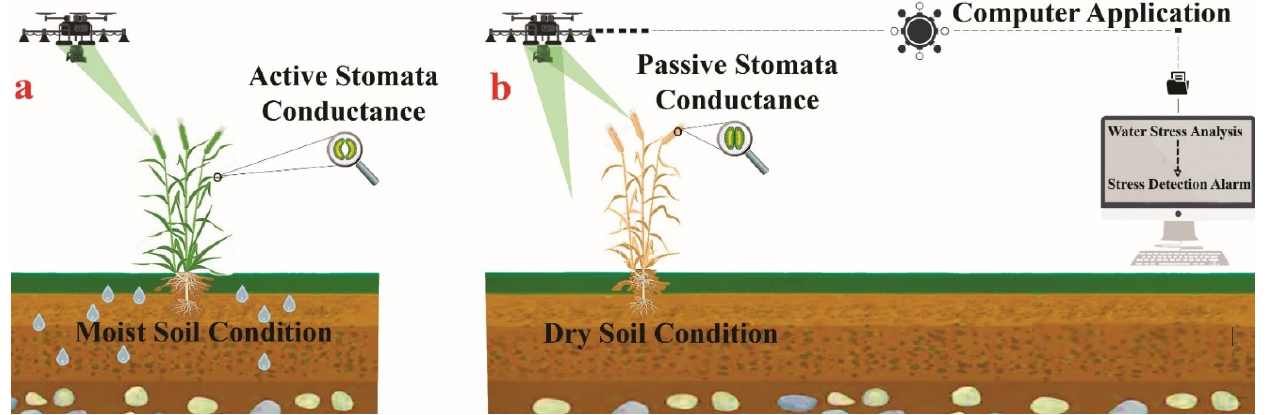
Figure 2. Crop water stress assessment: ( a ) Normal stomatal conductance with no stress retrieved, ( b ) comparison of irrigation water resources and micro-environmental conditions near the plant source to evaluate the intensity of the crop water stress content in real-time field conditions.